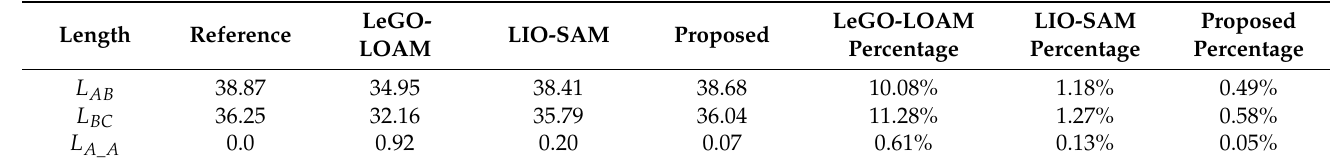
Table 2. Quantitative comparison of the proposed method, LIO-SAM and LeGO-LOAM (m).